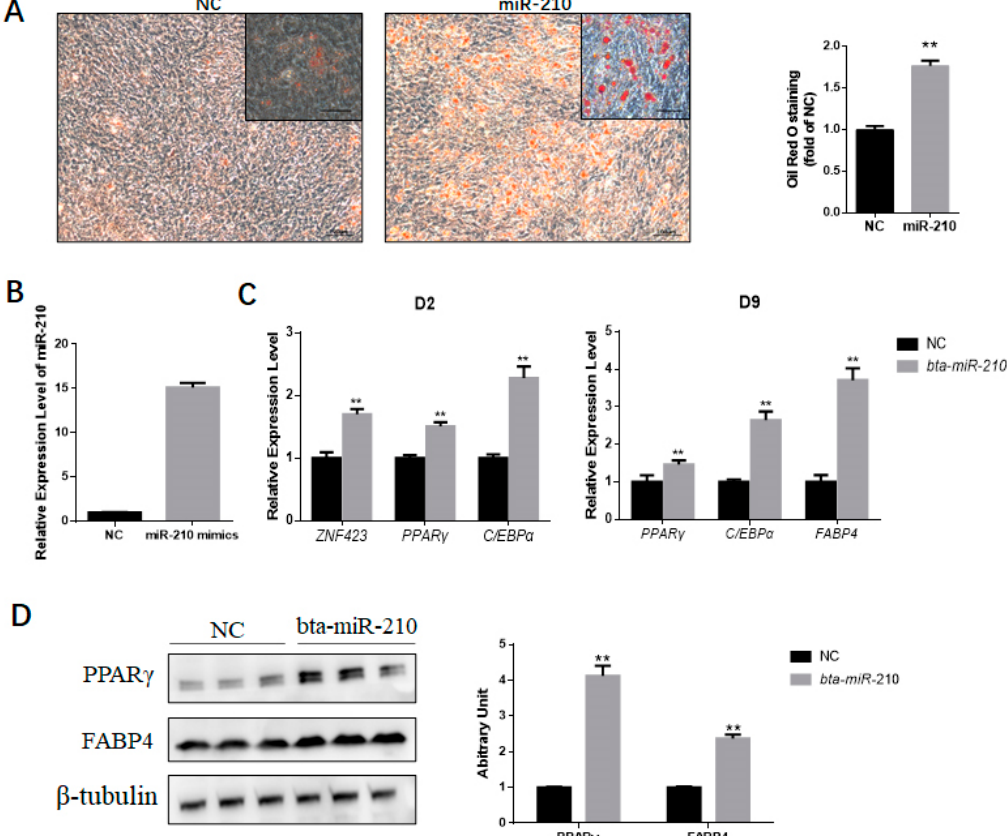
Figure 3. miR-210 enhances the adipogenic differentiation of PDGFR α + cells. ( A ) The accumulation of lipids was analyzed by the ORO staining of differentiated PDGFR α + cells transfected with NC or miR-210 mimics. Scale bar = 100 µ m, inset scale bar = 50 µ m. The quantification of the stained lipid droplets was conducted with eluted ORO stain by detecting the absorbance at 490 nm. ( B ) bta-miR-210 amount after mimic transfection. ( C ) Relative expression of adipocyte-specific genes on Day 2 (D2) and Day 9 (D9). ( D ) Representative Western blot results show PPAR γ and FABP4 contents in PDGFR α + cells treated with NC or miR-210 mimics, and the grayscale intensity was quantified. All the measurements shown are the means ± SEM of four biological replicates from independent cell experiments. NC, negative control. ** p < 0.01.